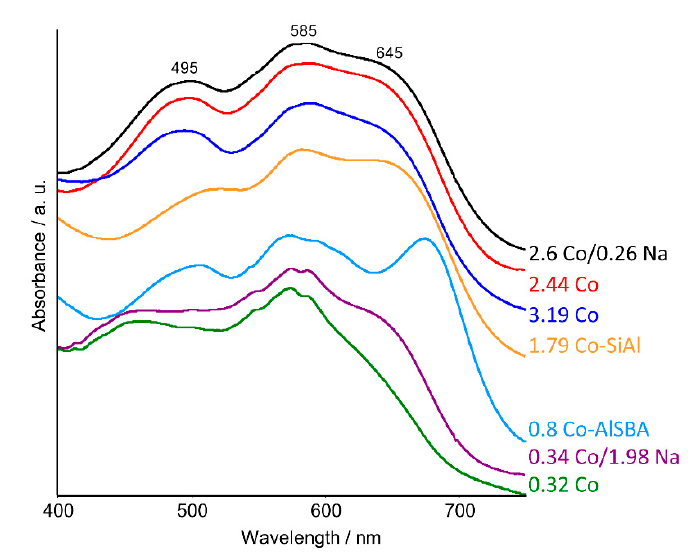
Figure 1. UV–Vis spectra measured in diffuse reflection mode at room temperature after heating the samples at 400 °C in He for 30 min.